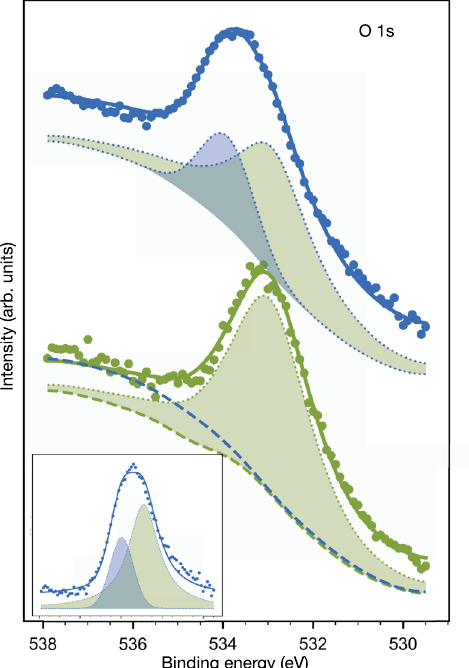
Fig. 6 | Curve deconvolution for O 1 s in FBI 0.6 ML on Au(111) before and after chelation. Detailof fi ttingcomponents(dottedlines)forO1 s inFBI0.6ML(green) and FBI 0.6 ML+BaCl 2 , θ =0.8 (blue) from Fig. 2a and b. Circles and solid lines representrawdataandbest fi trespectively.Thegreencomponentwas fi ttedtothe unchelated FBIdata(green circles) at532.95±0.05eV, with width 2.16±0.04eV at FWHM. This component was then fi xed in position and width for the chelated FBI data(bluedots).Anadditionalcomponentwas fi ttedtothechelatedFBICL,shown as blue fi lled area, at 533.91±0.05eV, with 1.41±0.05. These values were obtained from the fi t as free parameters. The background of each curve is shown as dashed linesingreenandbluerespectively.Inset:samebluecurveandcomponentswithits background